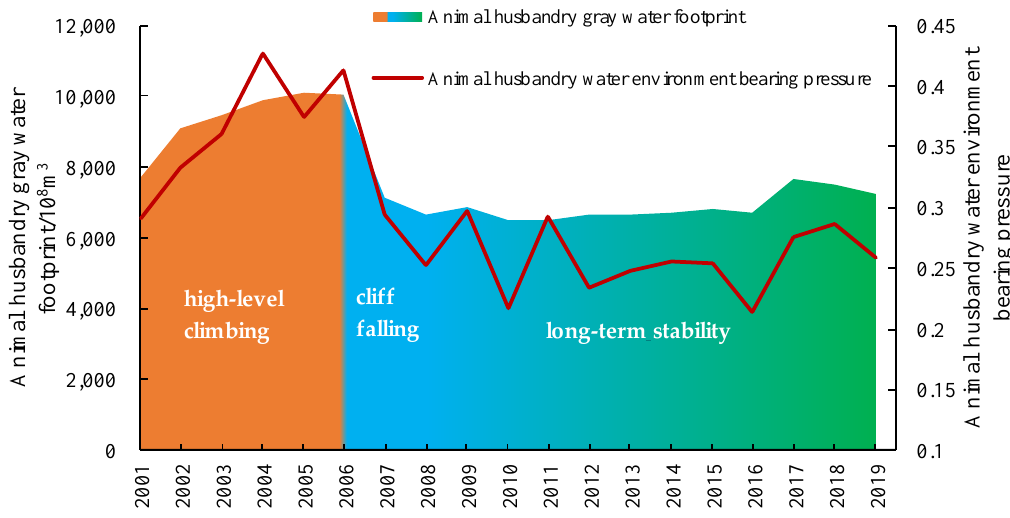
Figure 6. Animal husbandry gray water footprint and the variation trend of the water environment bearing pressure in China.